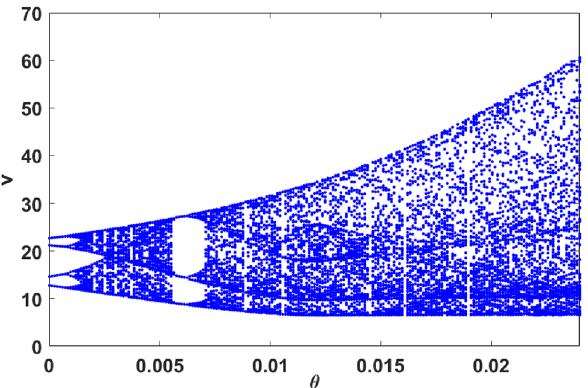
Figure 3. Bifurcation diagram of prey populations with respect to Allee parameter θ . Here we display the local maxima of the prey population. The parameter values in Eq. (1) are as mentioned in the text.